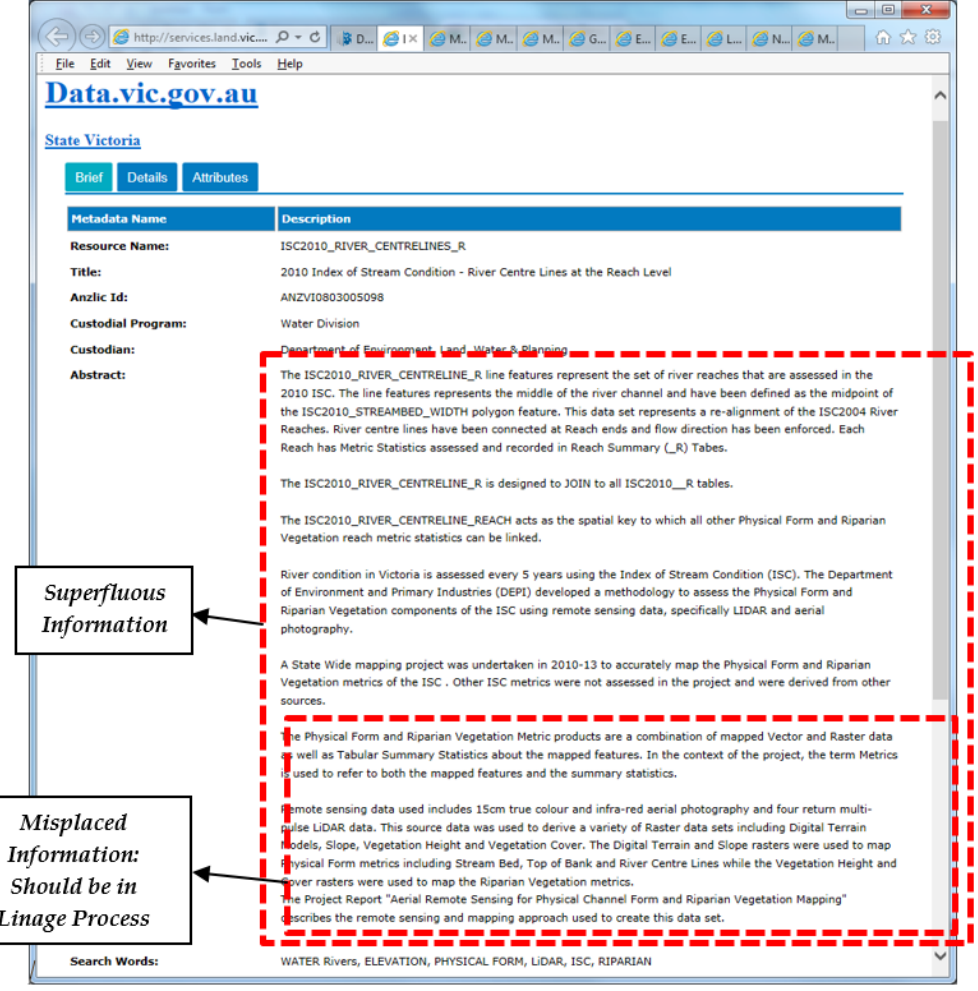
Figure 4. Superfluous information in an abstract.